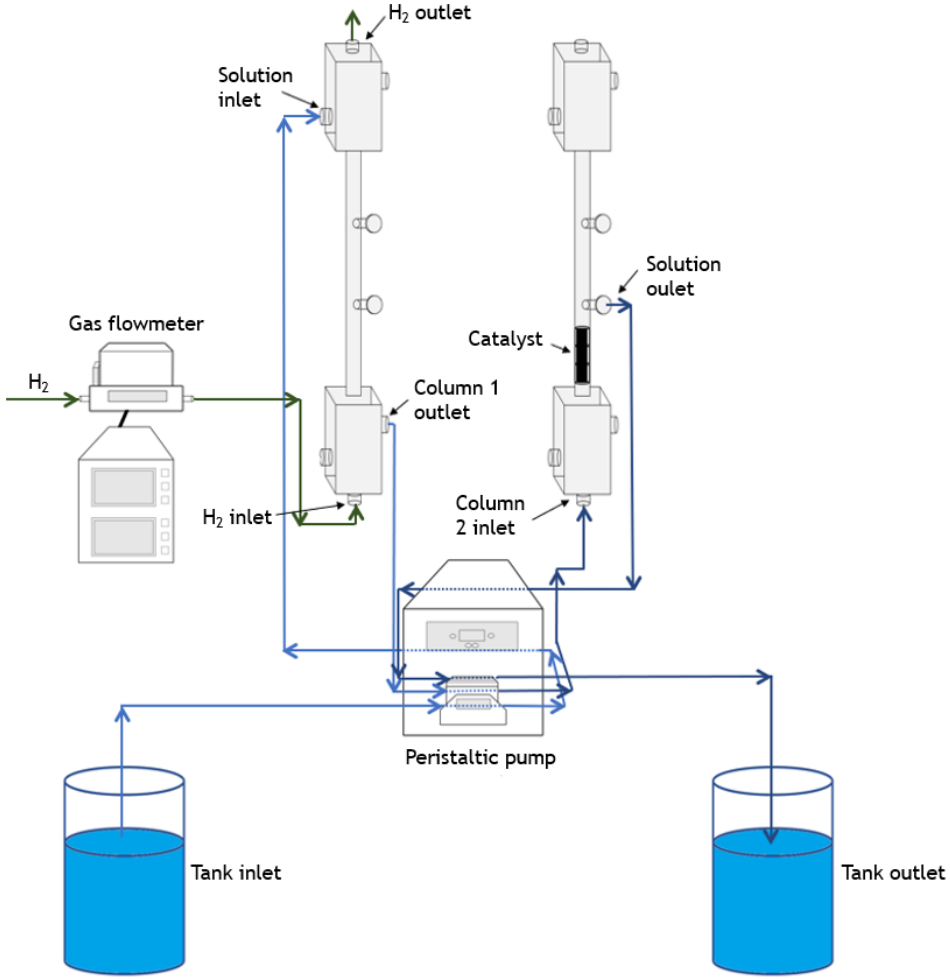
Figure 1. Schematic representation of the reactor system used for reduction of bromate in continuous mode. Table 1. Characteristics of groundwater obtained from a well and from a WTP in Coimbra,